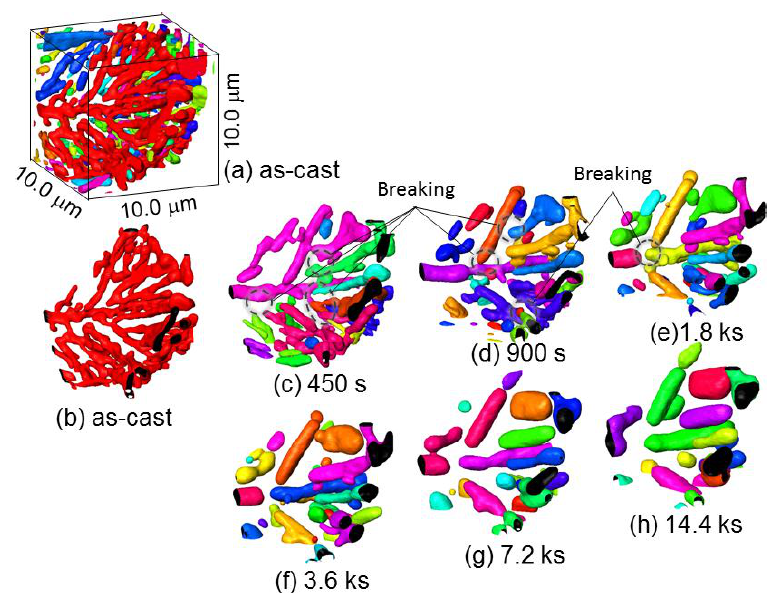
Figure 13. Magnified three-dimensional images of Si-particles in Al-10.1%Si-4ppmP-108ppmSr cast alloy. ( a ) as-cast, ( b ) as-cast (one particle), ( c ) heat-treated at 773 K for 450 ks, ( d ) heat-treated at 773 K for 900 ks, ( e ) heat-treated at 773 K for 1.8 ks, ( f ) heat-treated at 773 K for 3.6 ks, ( g ) heat-treated at 773 K for 7.2 ks, ( h ) heat-treated at 773 K for 14.4 ks.